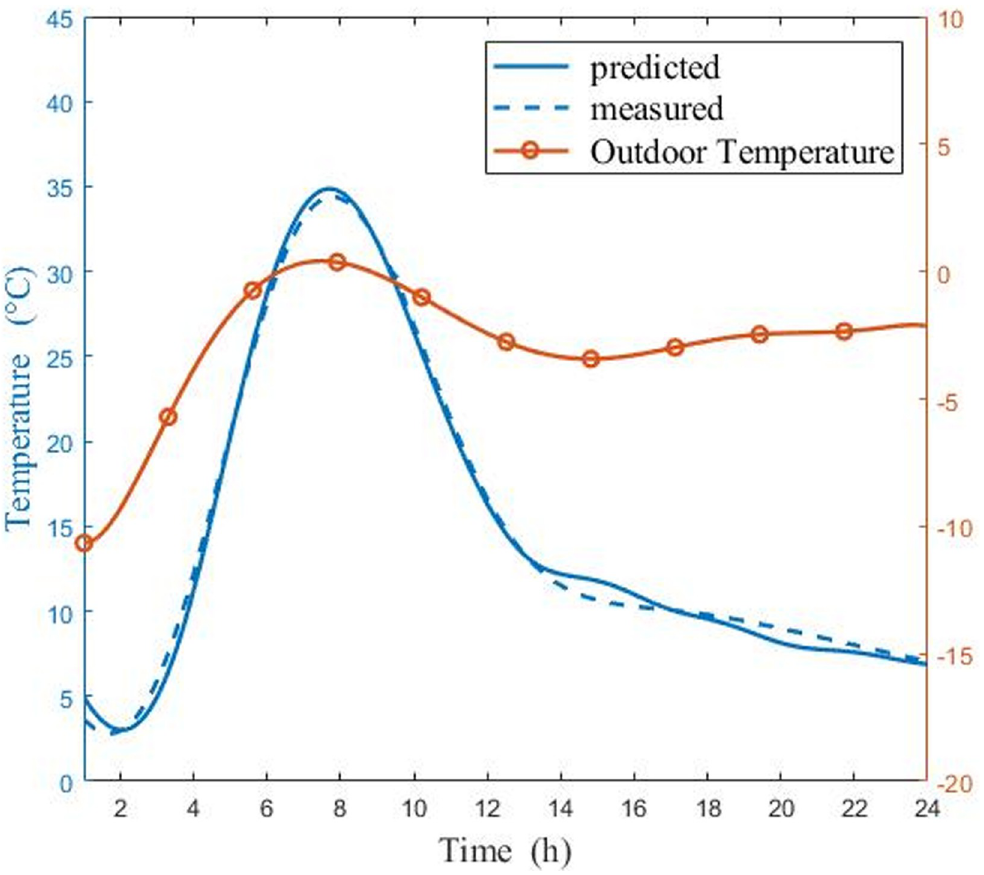
Fig 9. Comparisons of measured and predicted air temperatures in the CSG in sunny day (6:00 in the morning ~ 5:00 the next day).